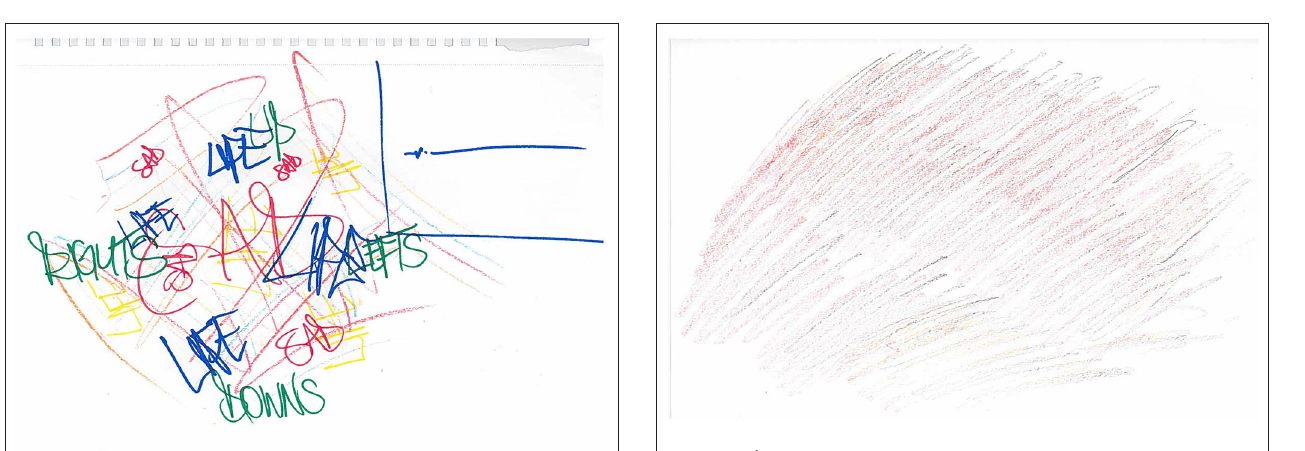
FIGURE 5 | WQ10 drawing of emotions experienced before suicide attempt.